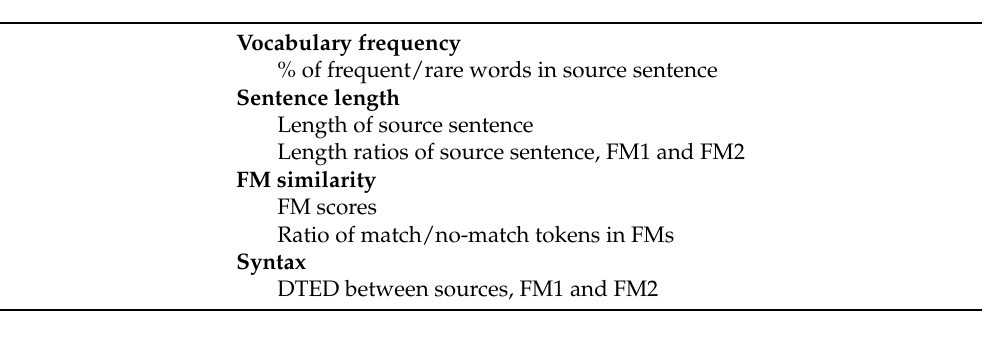
Table 5. Overview of candidate